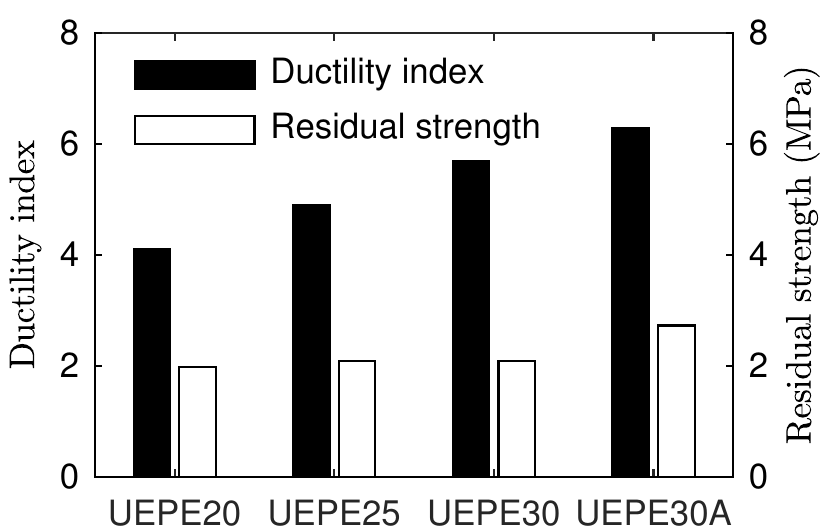
Figure 8. Ductility index and residual strength of the